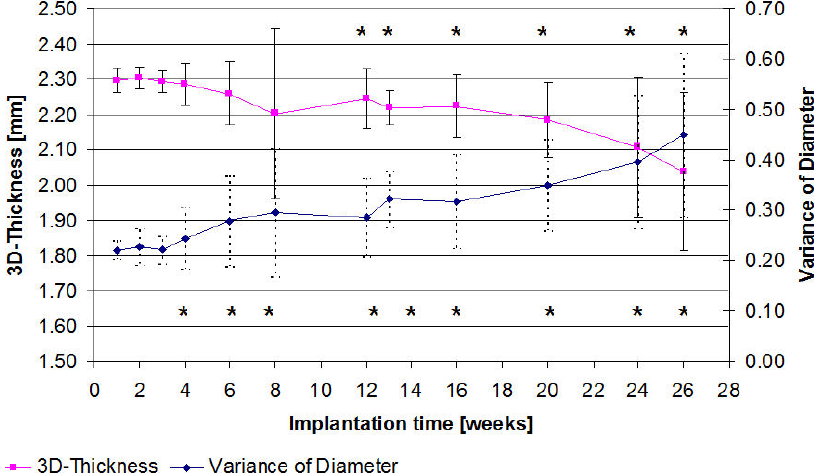
Figure 4. Representation of the 3D-thickness development and the variance of the implant’s diameter determined by µ-computed tomography plotted over the course of 26